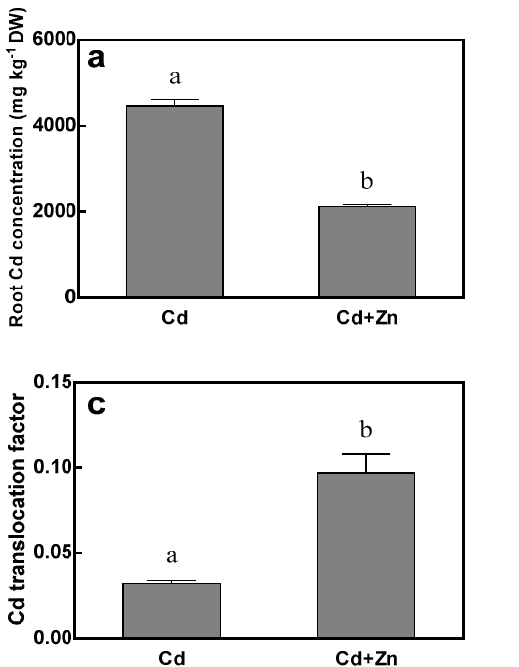
Figure 2. Cd concentrations of root ( a ) and shoot ( b ), and Cd translocation factor ( c ) of tall fescue. Plants were grown for 15 days in solutions under Cd (75 μ M Cd + 15 μ M Zn) and Cd + Zn (75 μ M Cd + 115 μ M Zn) treatments. Error bars represent ± SEM of three replicates. Means with a common letter did not differ significantly (Duncan’s test, p < 0.05). The two-way analysis was performed.